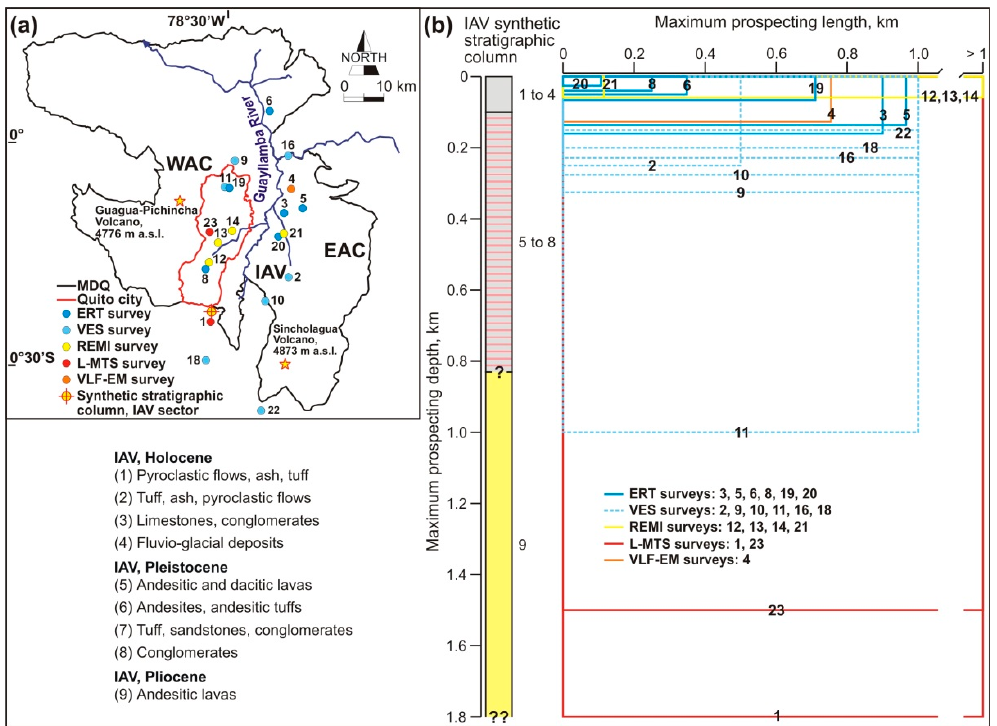
Figure 5. ( a ) General location of the 20 geophysical prospecting surveys in the IAV sector as shown in Figure 1b and Table 2; surveys 15 and 17 in the EAC sector and survey 7 in the WAC sector are excluded from this analysis. ( b ) A synthetic stratigraphic column of the IAV sector, as shown in Figure 1c. The typology and area covered by each geophysical prospecting survey are indicated. Acronyms ERT, VES, REMI, L-MTS, and VLF-EM are defined in Figure 1b.